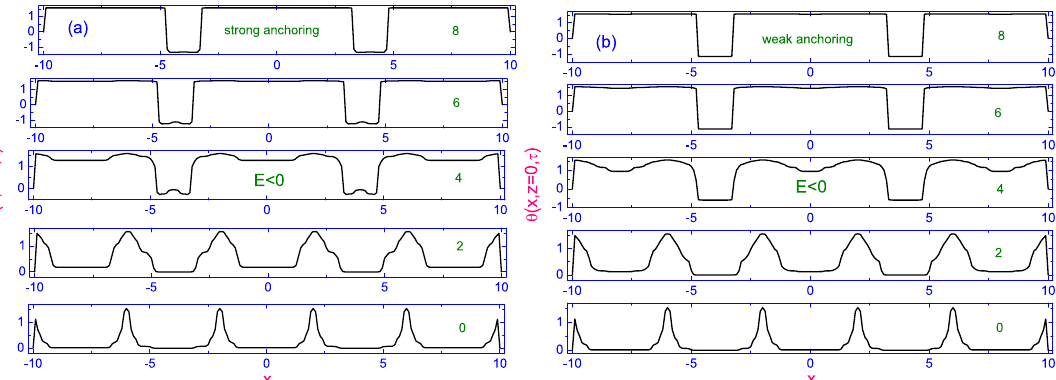
Figure 12. Plot of the evolution of the polar angle θ ( x,z = 0, τ ) to its equilibrium distribution along the length of the dimensionless nematic film ( − 10 ≤ x ≤ 10 ) for a number of dimensionless times τ = 0(248), 2 (250), 4 (252), 6 (254), and 8 (256), respectively. ( a ) shows the case B, while ( b ) shows the case A during the turned-on process in the negative sense (E < 0) [19]. In all these cases θ 0 = 0.01 ( ∼ 1.1 ◦ ) and α = − 1.57 ( ∼− 89.96 ◦ ) ).